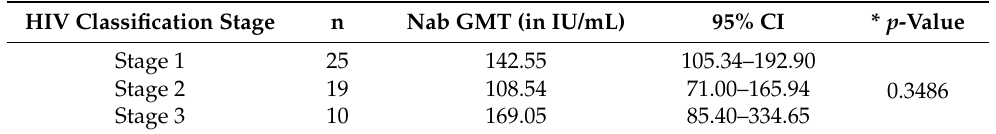
Table 4. Correlation analysis for HIV classification stage with post vaccination neutralization antibody